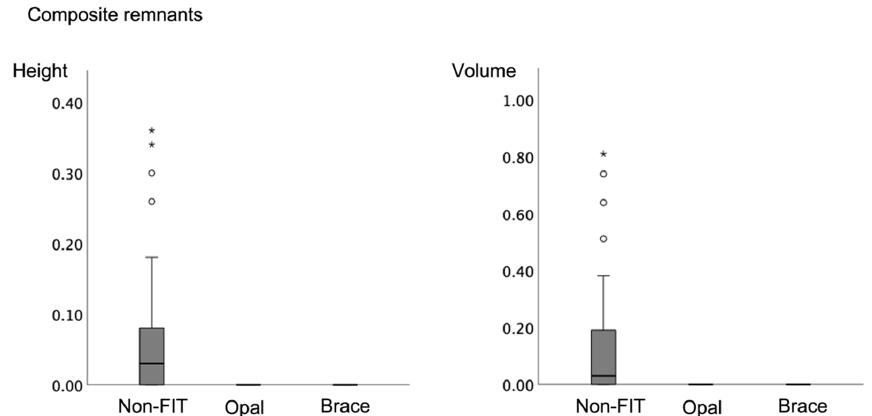
Figure 6. Composite remnant height ( left ) and composite remnant volume ( right ) values according